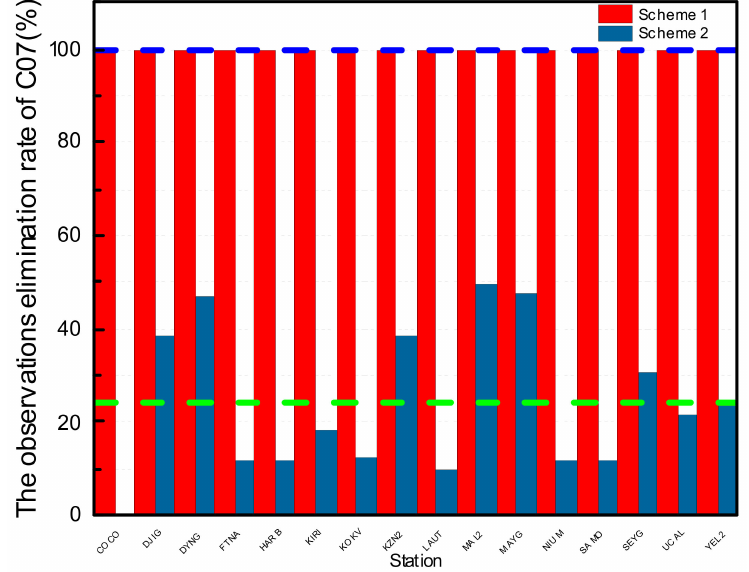
Figure 9. Observation elimination rate of stations for C07 from precise orbit determination on 16 October